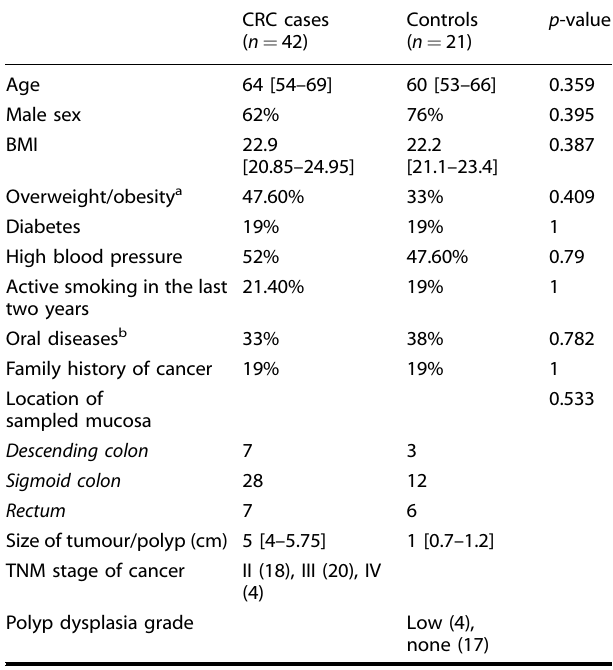
Table 1. Baseline characteristics of patients recruited in this